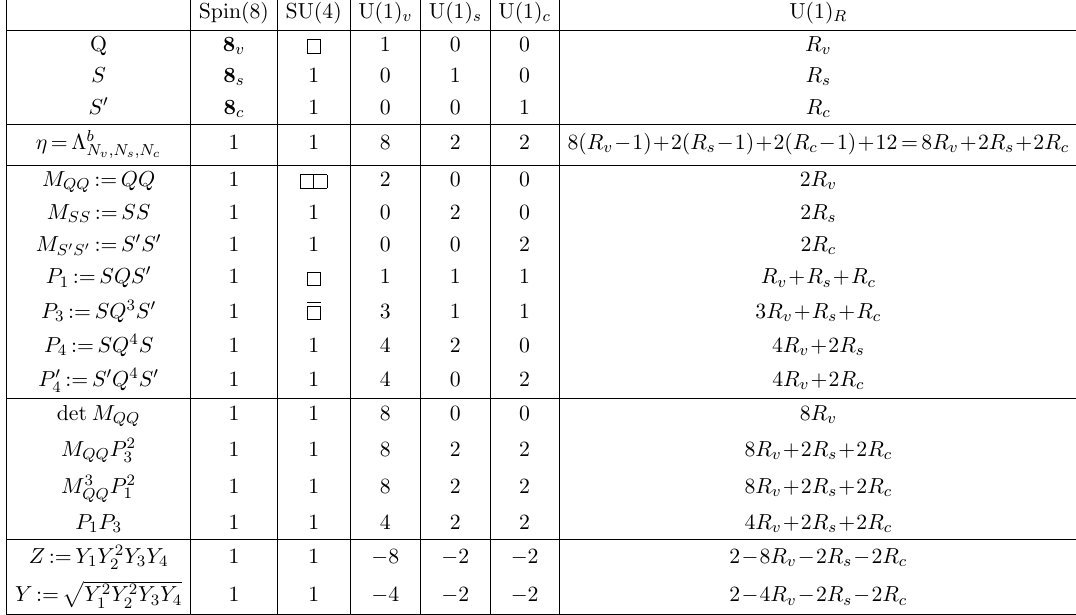
Table 3 . 3d N = 2 Spin(8) theory with ( N v ;N s ;N c ) = (4 ; 1 ; 1).